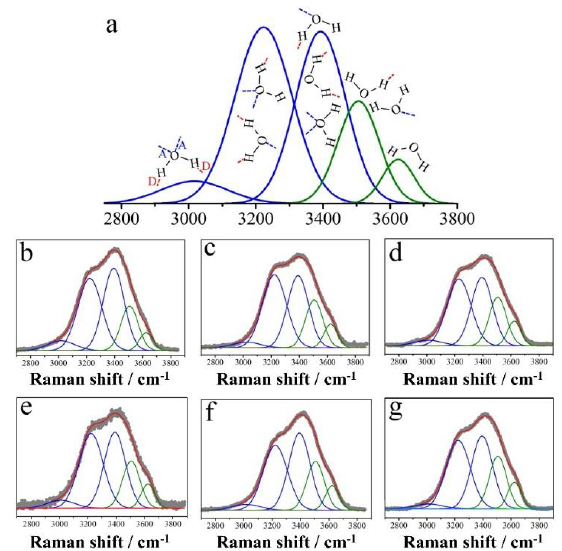
Figure 2. Assignments of five Gaussian components of OH stretching Raman bands and Raman spectra of OH stretching of various pure water and saline solutions. ( a ) In deconvolution, the five Gaussian components with the center wavenumbers at 3018, 3223, 3393, 3506, and 3624 cm −1 were adopted for all samples. The three components on the low frequency side are assigned to hydrogen-bonded water, while the remaining two high frequency side components are assigned to non-hydrogen-bonded water. The full width at half maximum (FWHM) of the individual component in the five-Gaussian fit was equal for all samples. These values are 234, 201, 176, 154, and 112 cm −1 for bands at 3018, 3223, 3393, 3506 and 3624 cm −1 , respectively. Red capital letter D and blue capital letter A are noted as donor and acceptor of proton, respectively; ( b ) DI water for reference; ( c ) AuNT water (also called PAW) under illumination with fluorescent lamps in preparation; ( d ) sAuNT water (also called PAW) under illumination with green LED in preparation; ( e ) DI water with 0.9 wt % NaCl; ( f ) AuNT water with 0.9 wt % NaCl; ( g ) sAuNT water with 0.9 wt % NaCl [67].